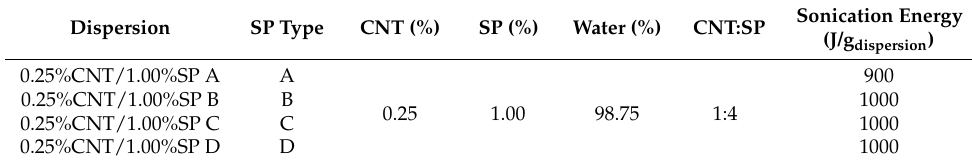
Table 2. CNT:SP proportions and total sonication energy for each CNT dispersion.